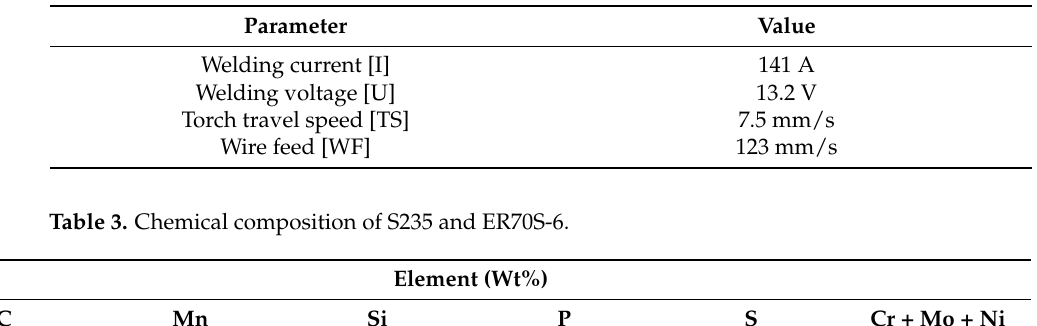
Table 2. Welding parameters.